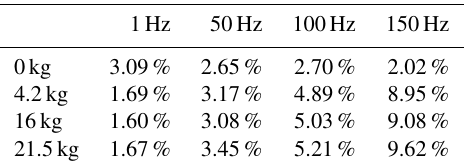
Table 3. Model Estimation